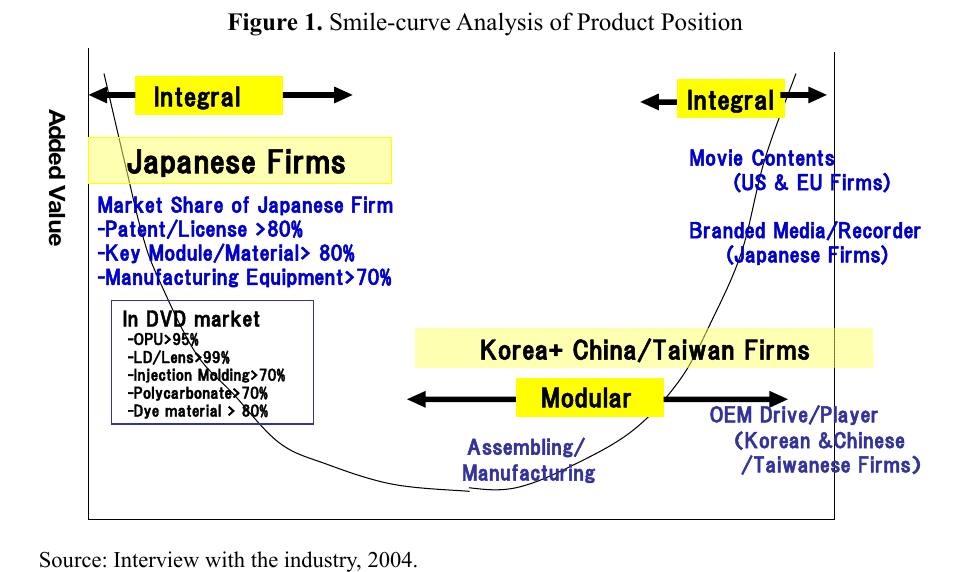
Figure 1. Smile-curve Analysis of Product Position